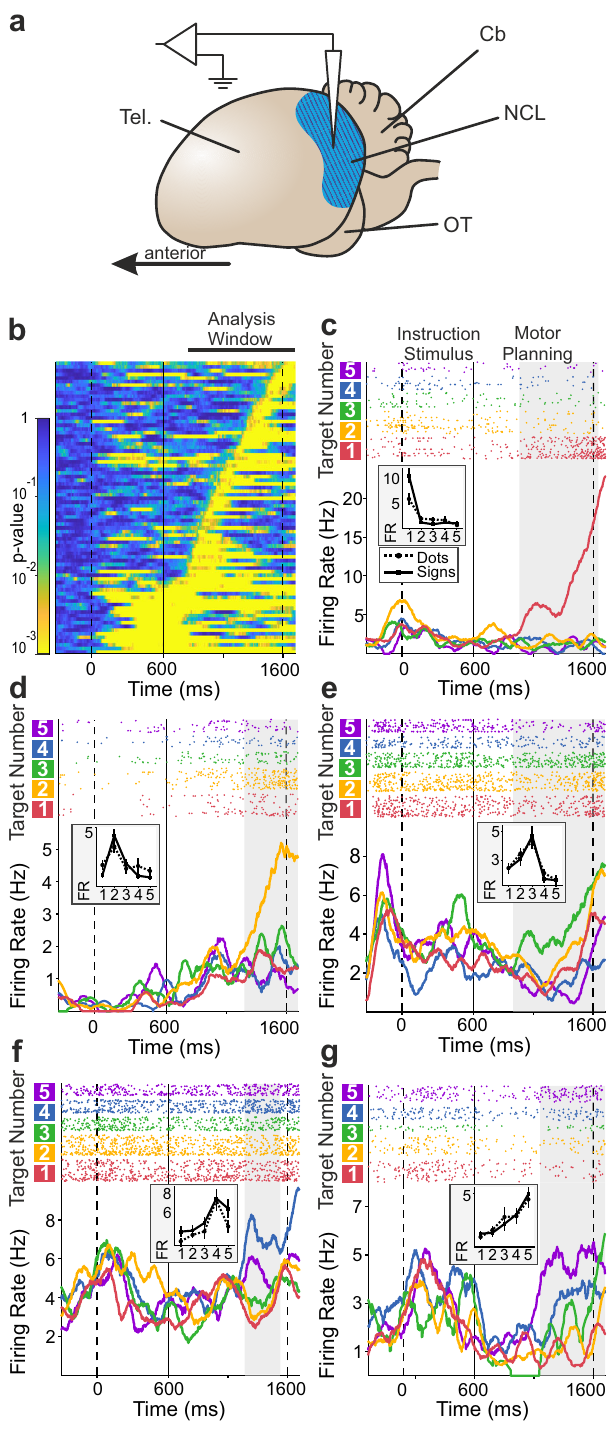
pecks than instructed. We found that neuronal activity to the respec- tive preferred target number was signi fi cantly reduced for incorrect trials compared to activity from correct trials (correct vs. incorrect: neurons, Wilcoxon signed-rank test) (Fig. 4c). This indicates that the